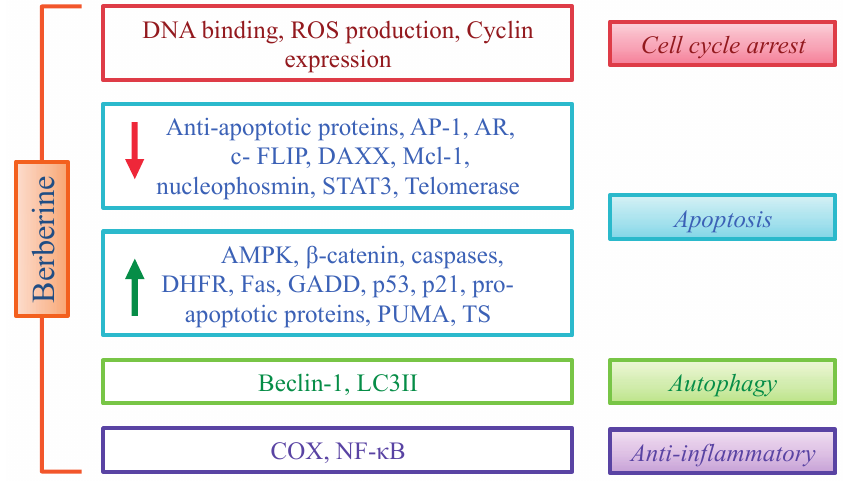
Figure 2. Effect of BBR on cell cycle, apoptosis, autophagy and inflammation through the modulation of different